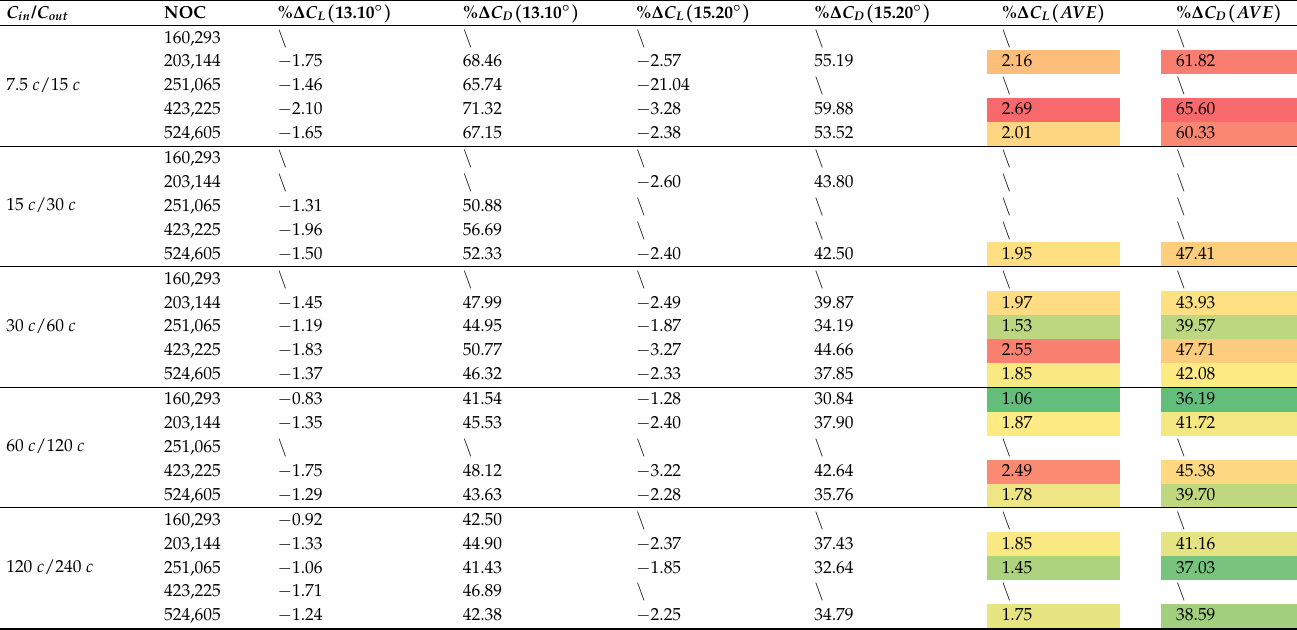
Table 5. Comparison of results of C-mesh based on various domain sizes with that of experimental benchmark data adopted from [25] in relative